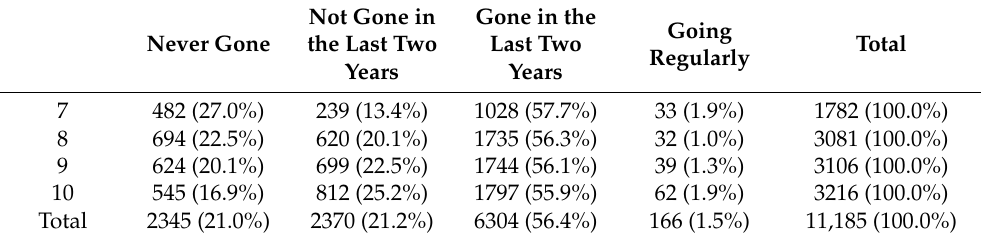
Table 5. Children’s dental visits [n